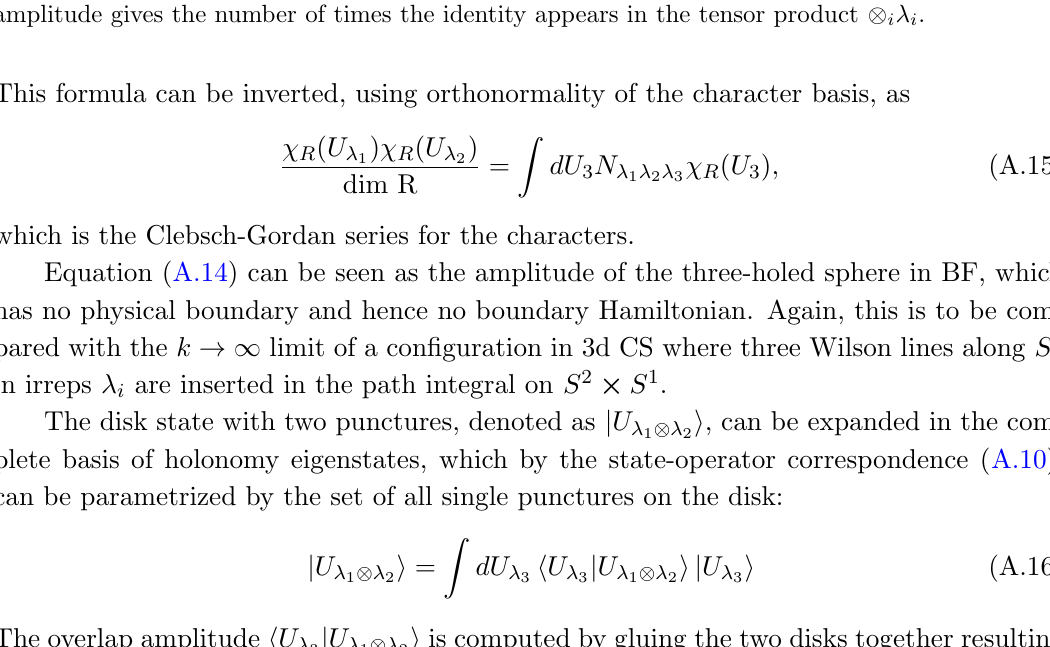
Figure 11 . Left: fusion coe(cid:14)cient as three-holed sphere in BF. Right: generic n -hole sphere amplitude gives the number of times the identity appears in the tensor product (cid:10) i (cid:21) i